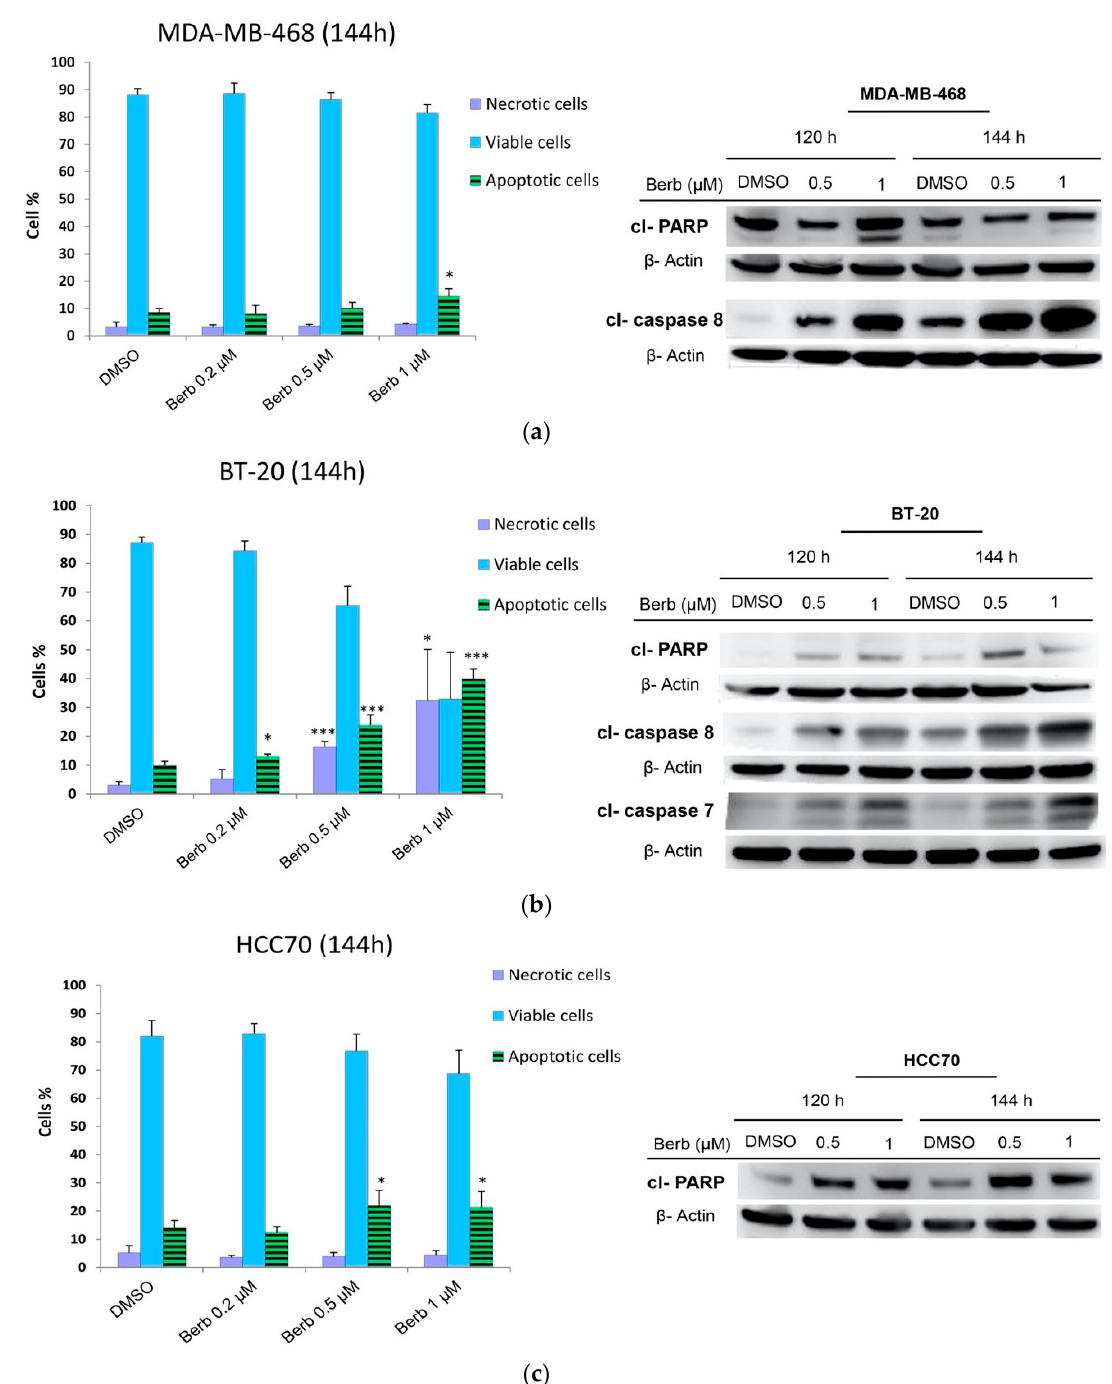
Figure 7. Berberine induced apoptosis in a dose and time dependent manner. Annexin-V and PI staining after 144 h of the treatment with berberine at 0.2, 0.5 and 1 µM. Western blot results of three independent experiments showing apoptosis related proteins expression upon berberine’s treatment at 120 h and 144 h. ( a ) MDA-MB-468, ( b ) BT-20, and ( c ) HCC70. ±SD of three independent experiments, * p < 0.05, ** p < 0.01 and *** p < 0.001 compared to DMSO. Berb—Berberine.